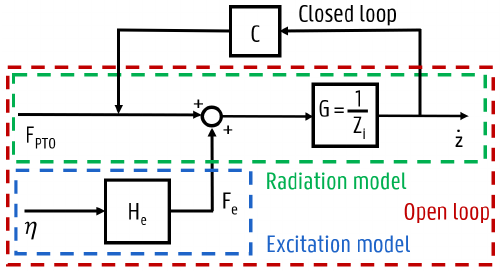
Figure 9. WEC block diagram based on the dual single input single ouput (SISO) radiation/diffraction